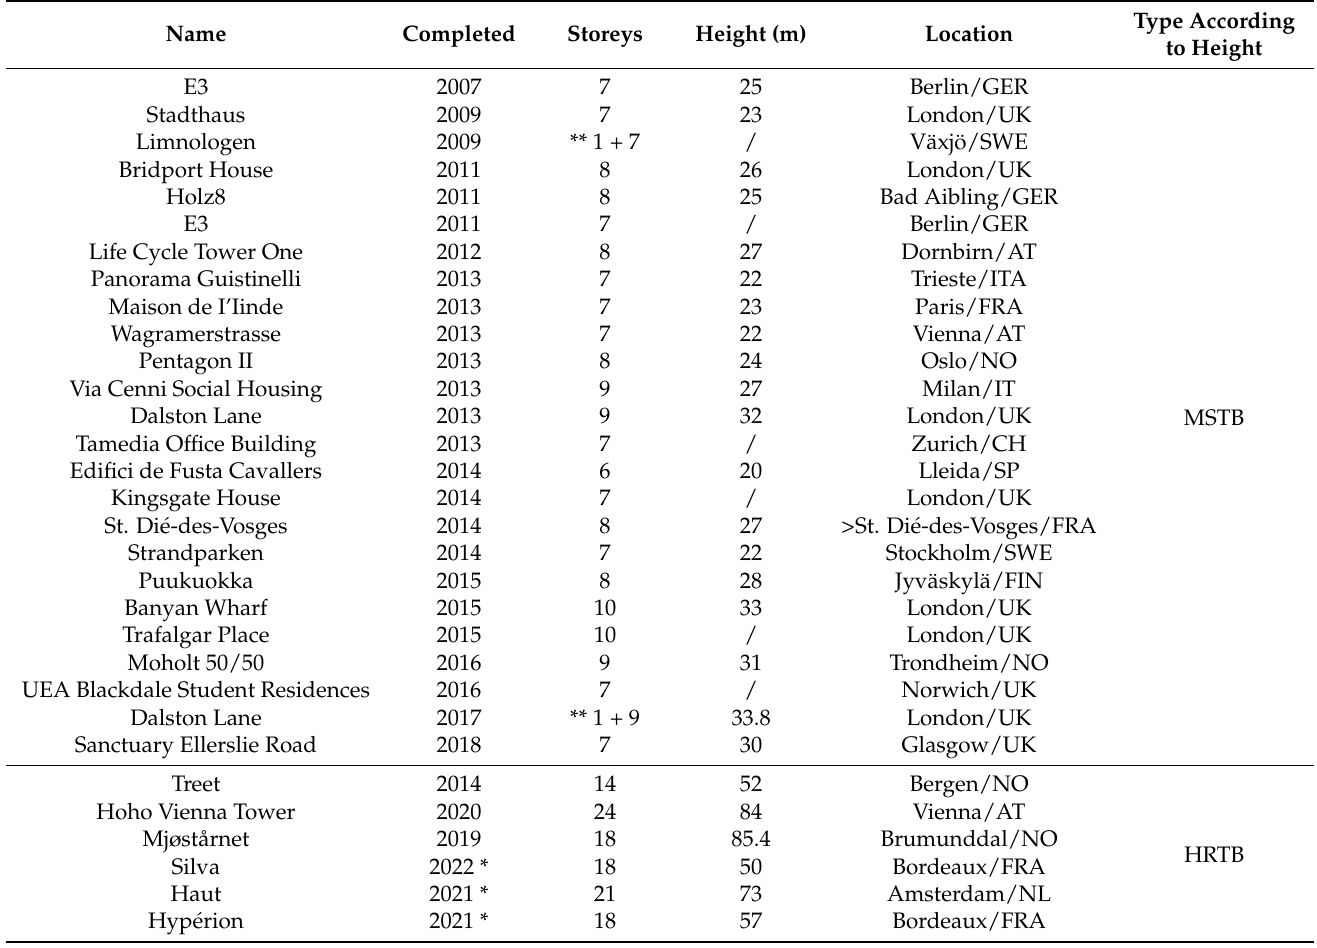
Table 1. Overview of MSTB and HRTB in Europe—data adapted from [3] and